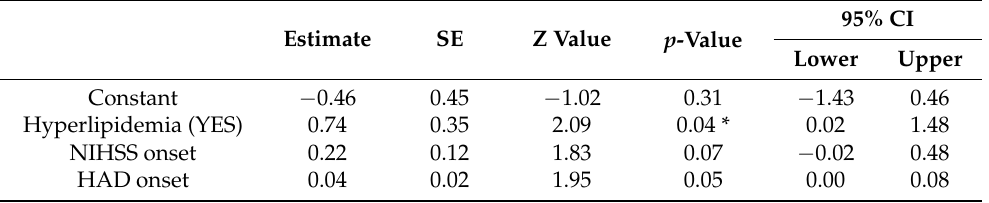
Table 3. Factors associated with the delay in months needed to RTpW.